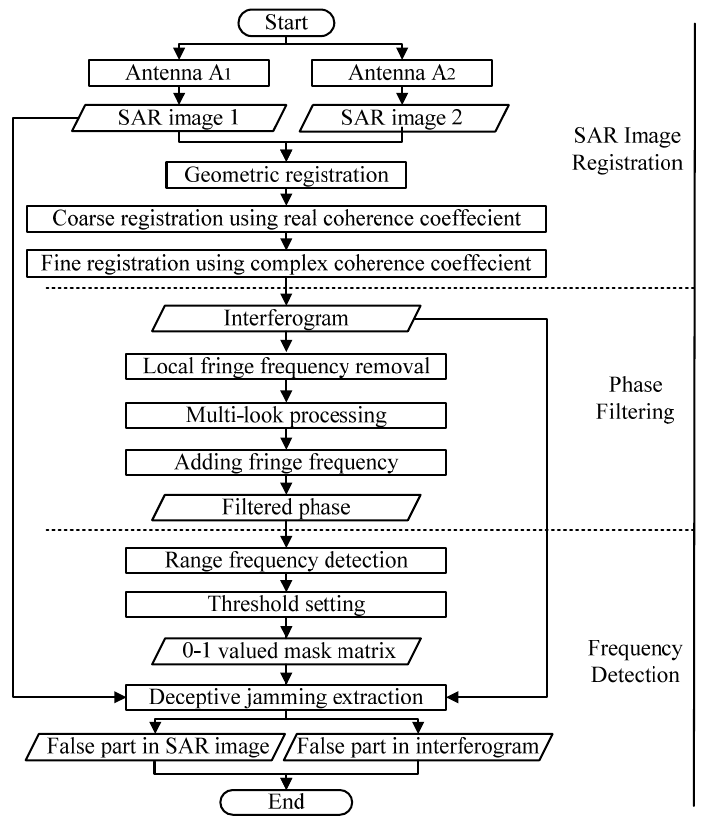
Figure 4. Detailed steps of the proposed SAR deception detection method.